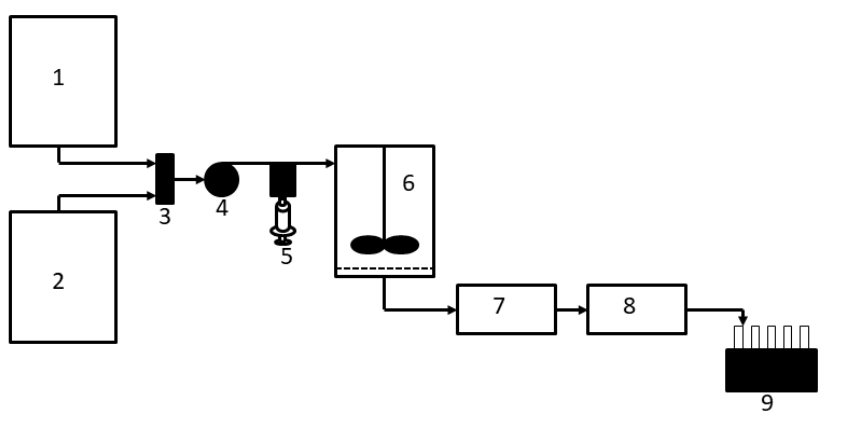
Figure 2. Set-up used for stirred cell membrane filtration-based hybrid separation of PEGylated